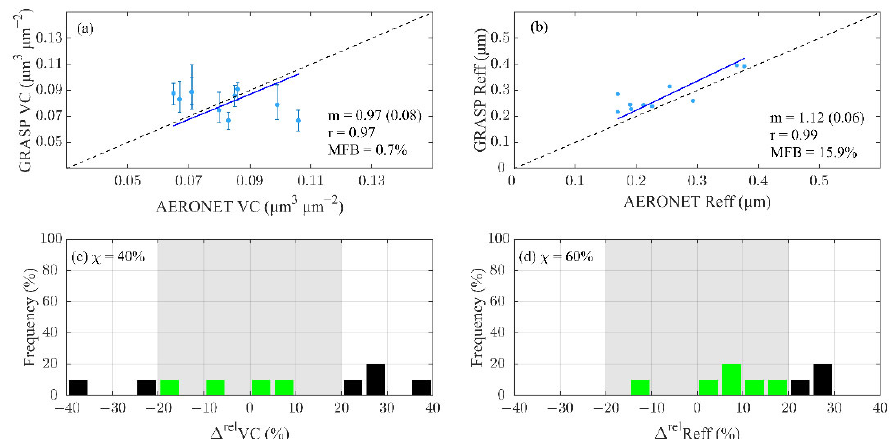
Figure 2. Comparison between GRASP and AERONET retrievals of the more representative prop- erties of columnar aerosol size distribution: (Left) total volume concentration (VC, µ m 3 µ m − 2 ) and (Right) effective radius (Reff, µ m). ( a ) and ( b ) Linear regression for each parameter was performed, showing the slope (m, with their error in brackets) and the correlation coefficient (r). The dark blue line represents the linear fit, while the dashed line is the 1:1 line. Light blue lines in ( a ) represent the error for the VC. The mean fractional bias (MFB) for each parameter is also included. ( c ) and ( d ) Relative differences ( ∆ rel , %) for each parameter, together with the optimal occurrence ( χ , %) of biomass-burning cases that fulfil ± 20% of ∆ rel (as marked by a grey band, green bars).